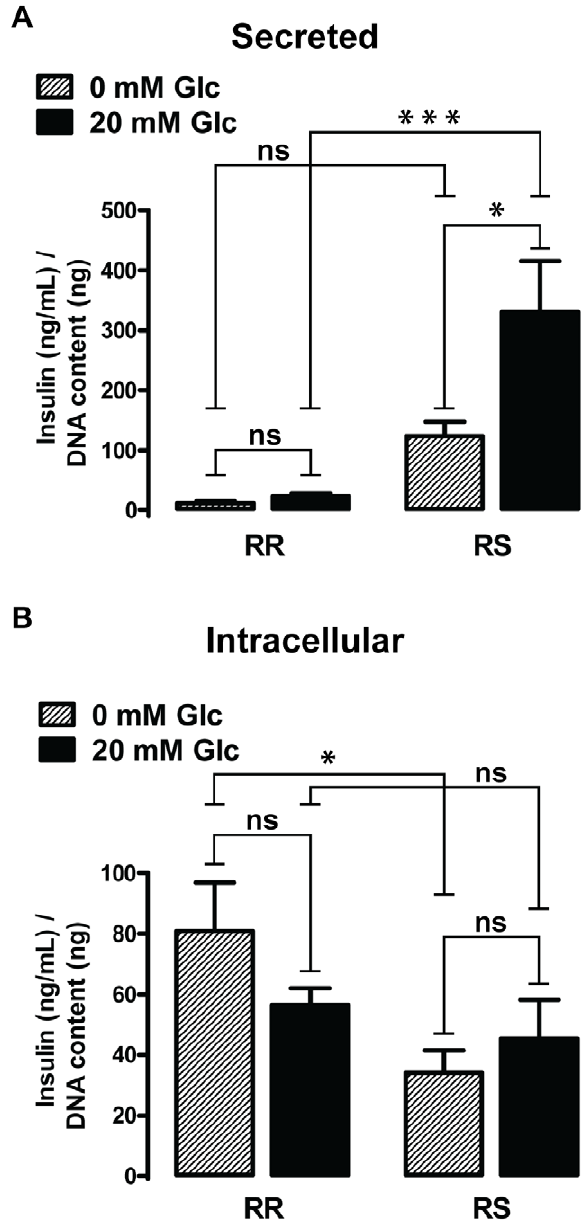
Figure 10. Differences in glucose-induced insulin secretion and intracellular insulin content. A . Insulin secretion is induced by 20 mM glucose in RS but not in RR cells. B . Intracellular insulin content is modestly but significantly lower in RS than RR cells at 0 mM glucose; there is no difference between the two cell types following the high glucose challenge. Statistical significance was determined by two-way ANOVA followed by ad-hoc Bonferroni post-tests (n=4); all data are plotted as mean 6 S.E.M. *, p , 0.05; ***, p ,